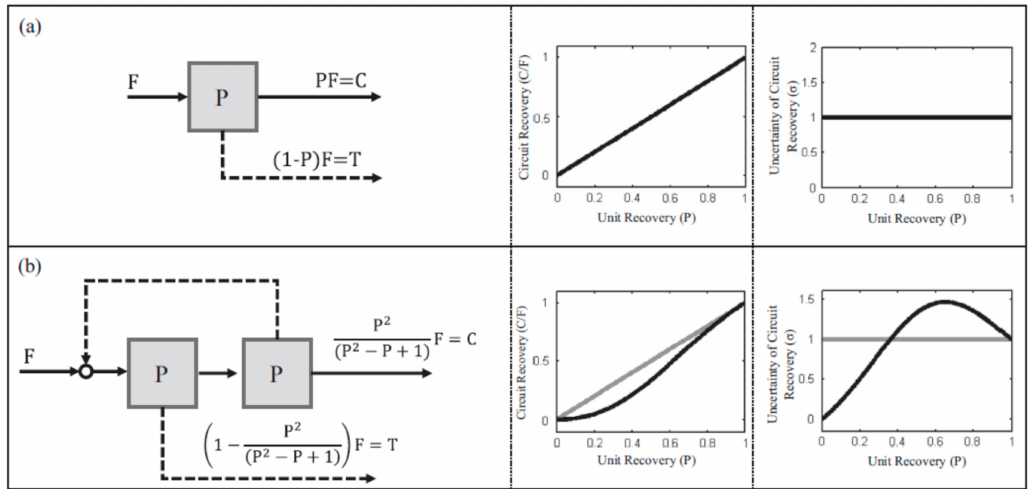
Figure 7. Linear circuit analysis (LCA) formulation example, including uncertainty analysis: ( a ) individual unit, ( b ) two-stage circuit